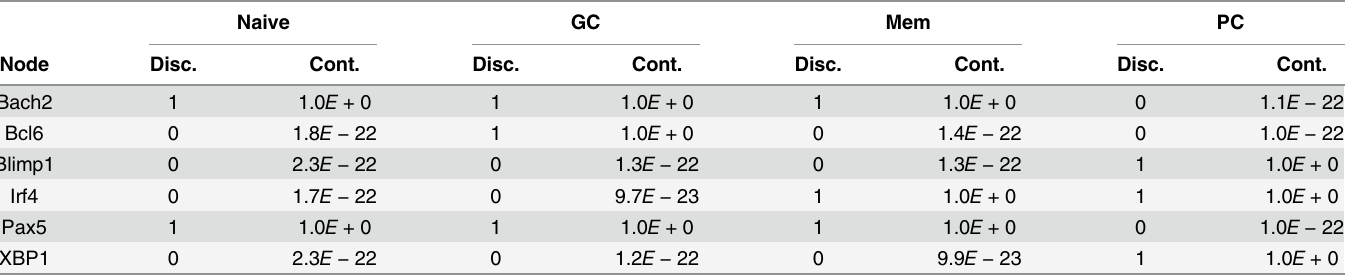
Table 1. Attractors of the discrete and continuous models of the B cell regulatory network.